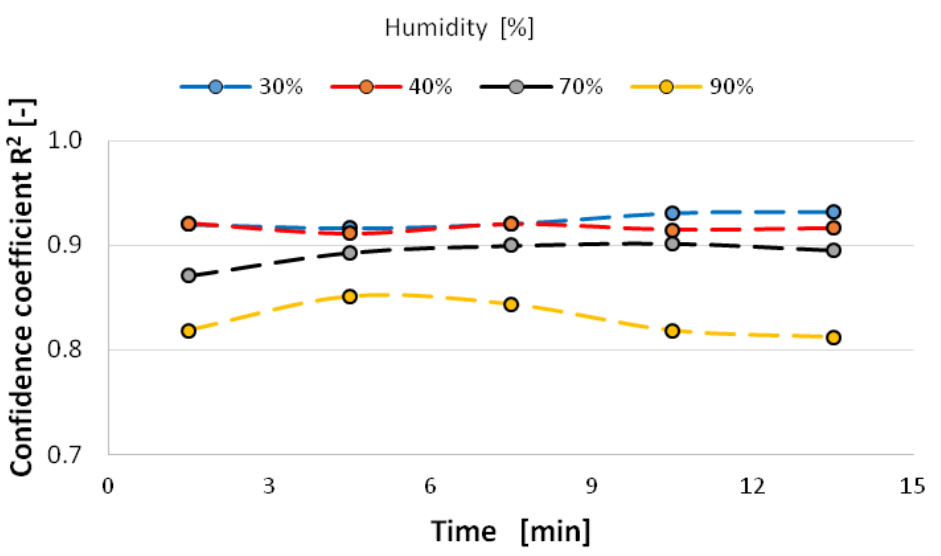
Figure 15. Confidence factor of the directional coefficient value as a function of time and ambient humidity during atomization.